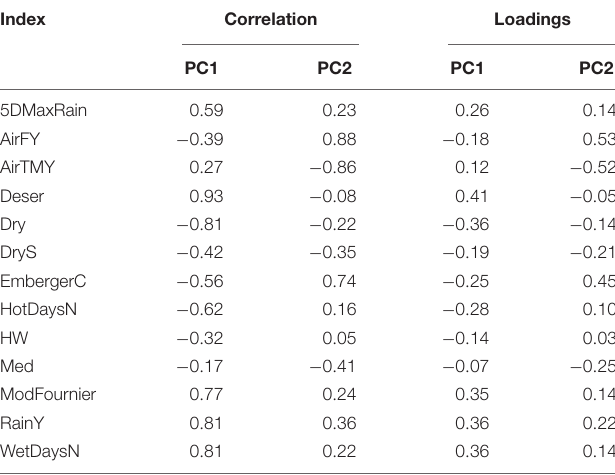
The acronyms of the agrometeorological indices are explained in Table 1